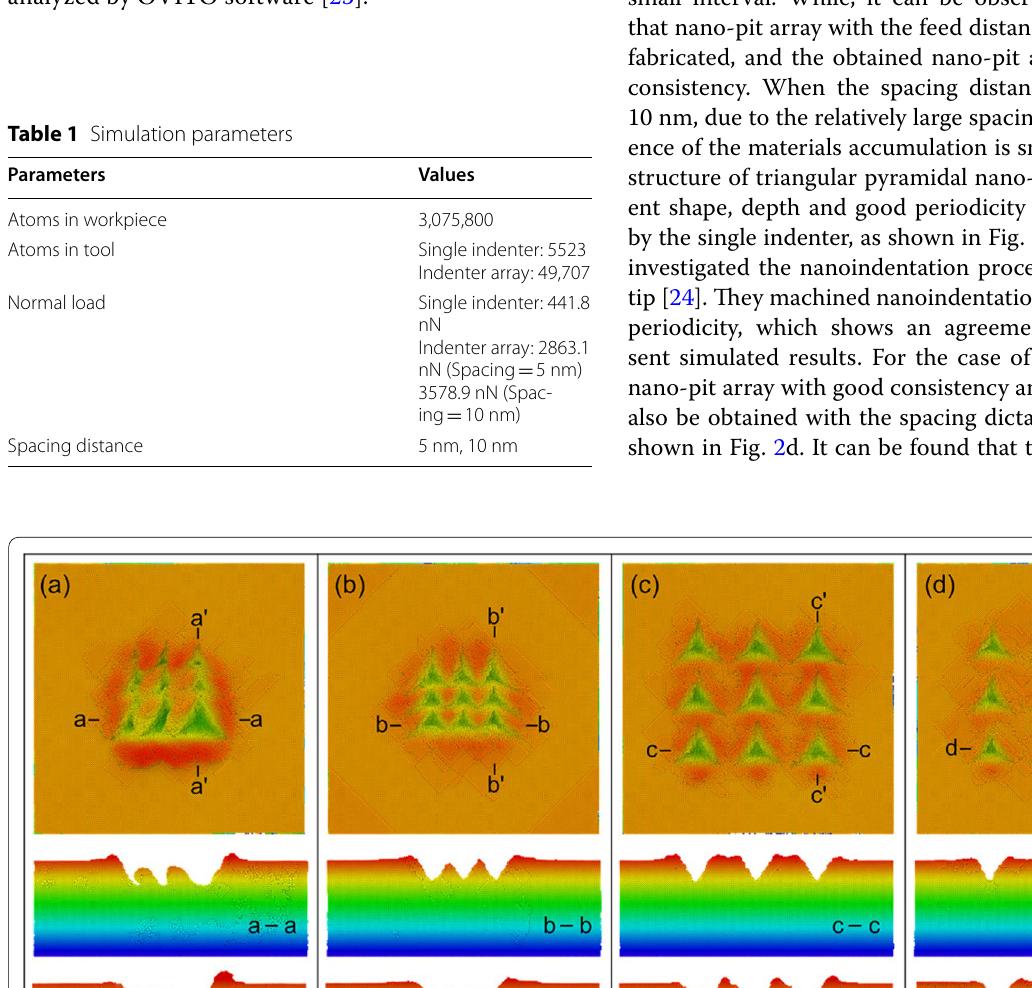
5 nm, c indenter with feed =